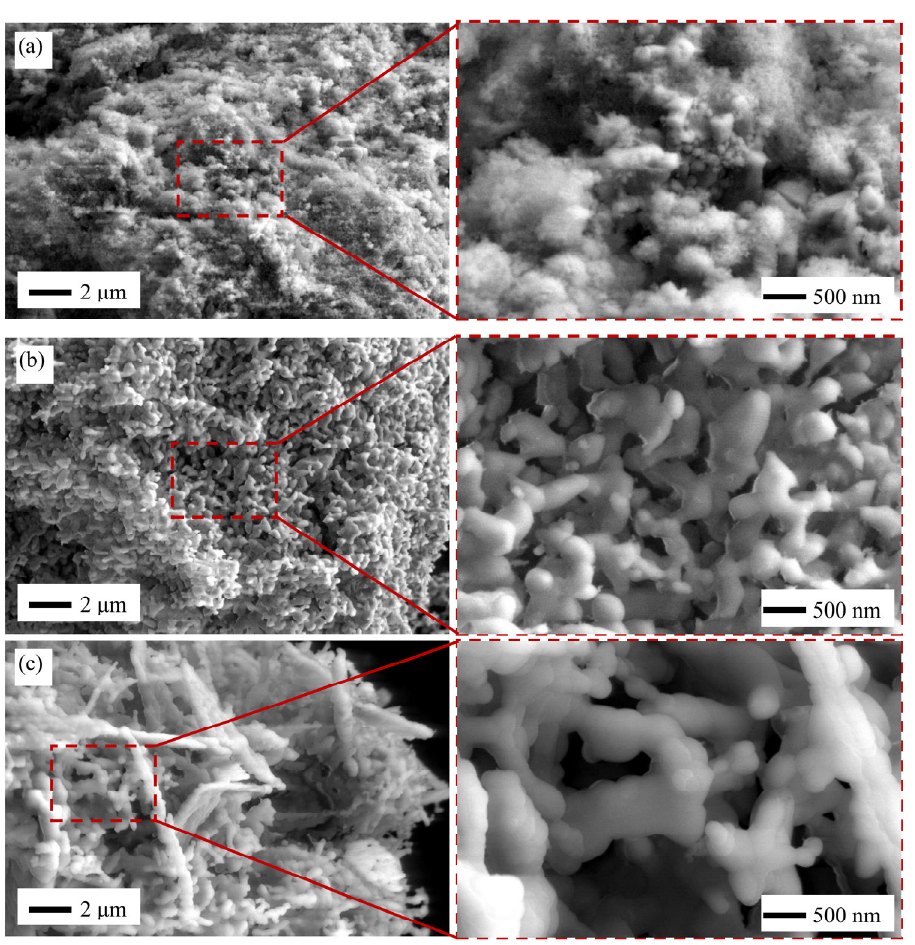
Figure 3. SEM images of HAp synthesized by ( a ) microwave, ( b ) coprecipitation, and ( c ) sol–gel with its magnification.